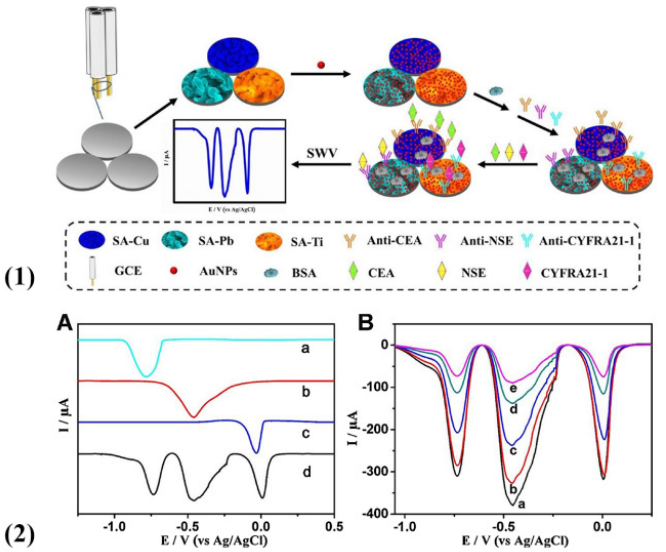
Figure 2. ( 1 ) Schematic for the fabrication process of the immunosensing interface. ( 2 ) Typical SWV signals of SA − Cu (a), SA − Pb (b), SA − Ti (c), and a mixture of these three hydrogels (d) ( A ). SWV characterizations of the modified procedure of electrodes ( B ) (reprinted with permission from Ref. [43], Copyright 2018, Elsevier).